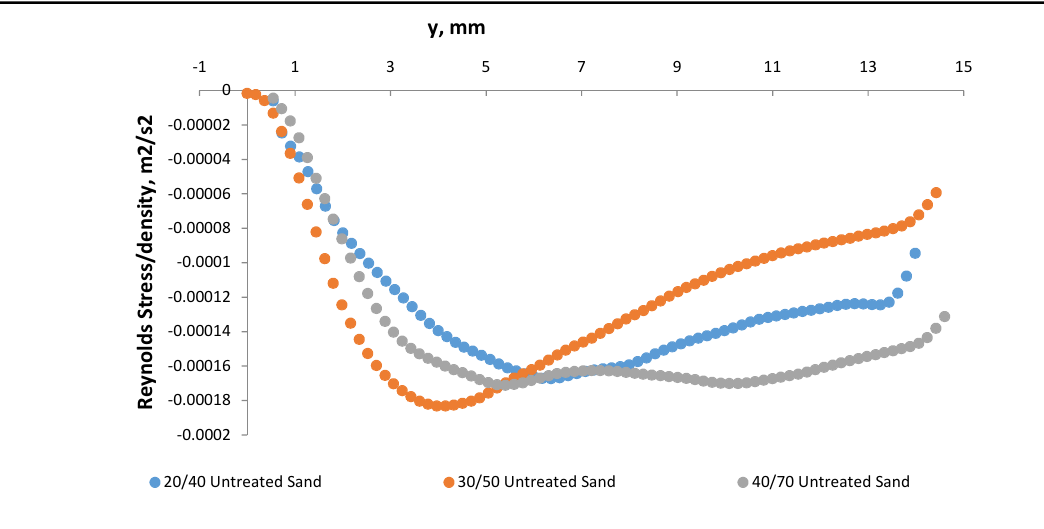
Figure 8. Reynolds stress profiles for the flow of polymer fluid over the sand bed at the superficial velocity of 0.25 m/s.